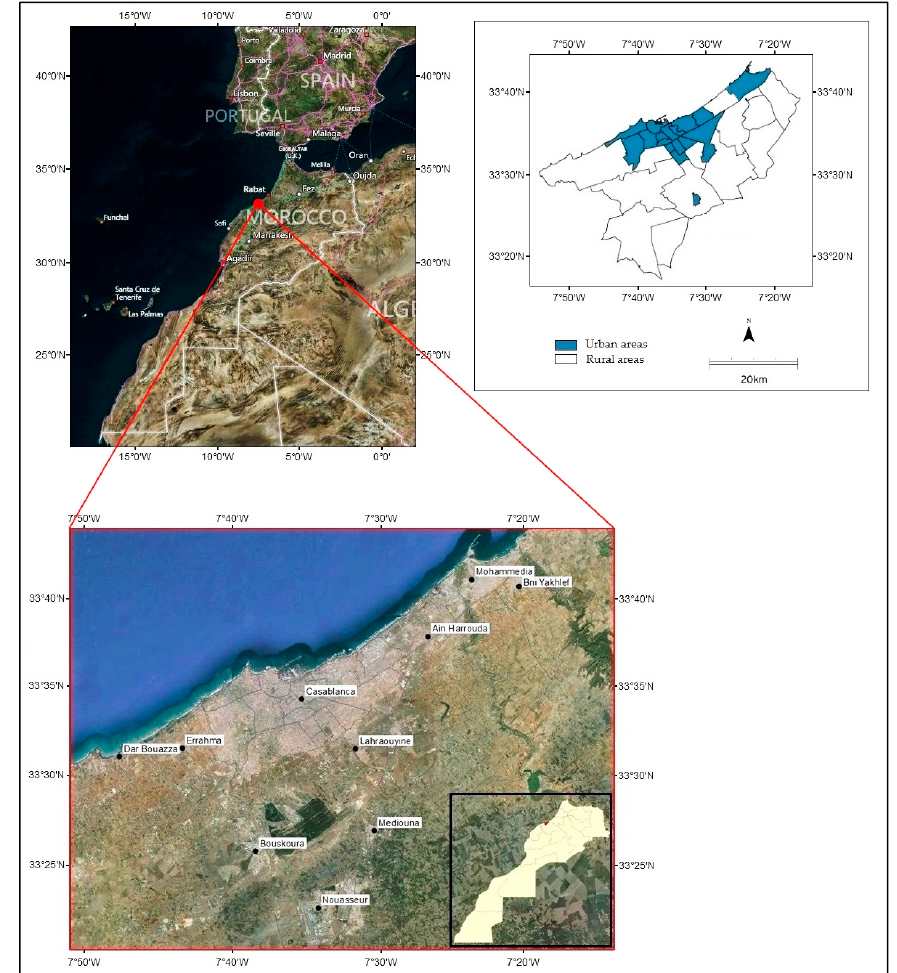
Figure 1. Study area showing Casablanca and its satellite cities.